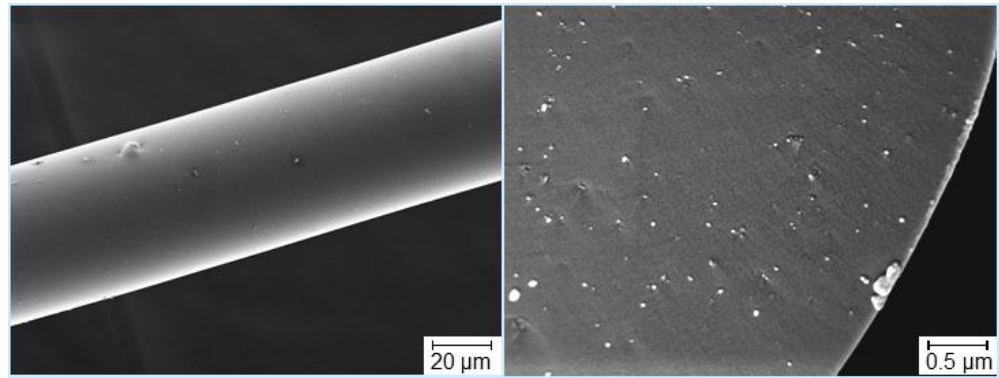
Figure 2. Polycarbosilazane-derived ceramic fibers with well dispersed nanotubes